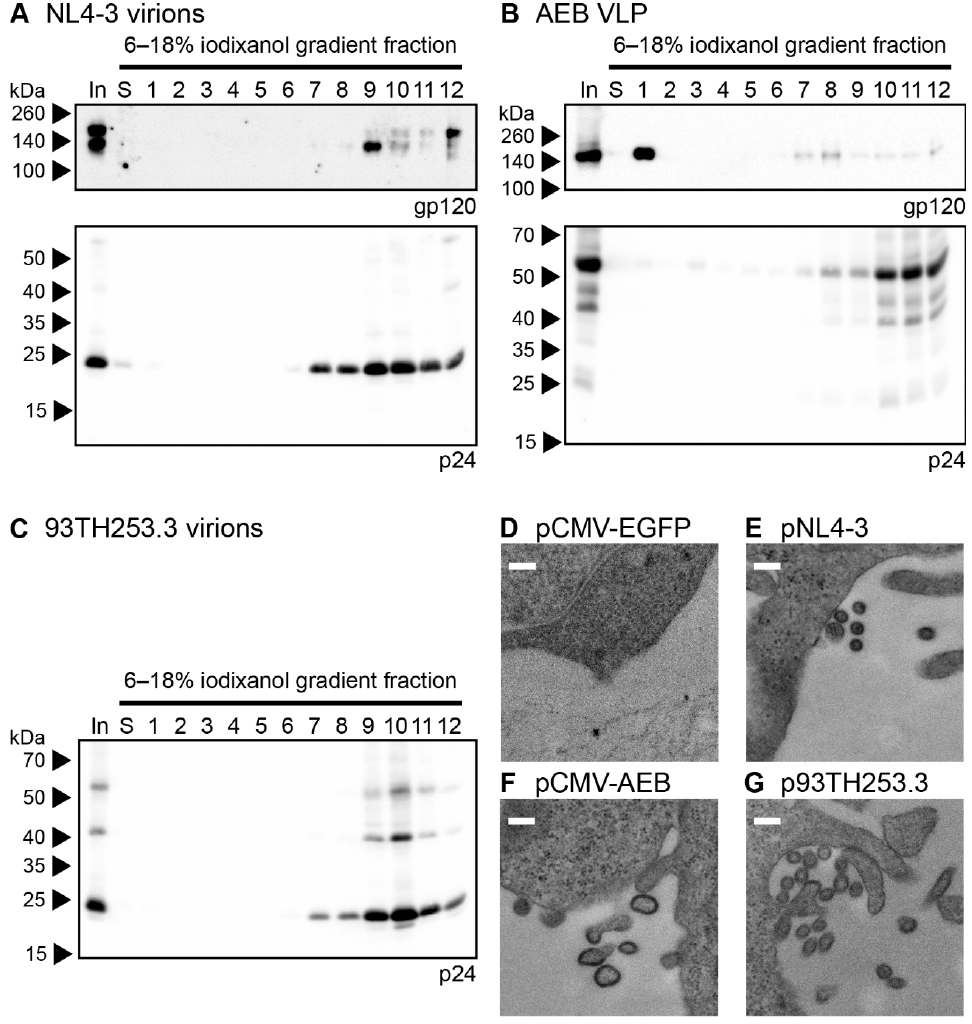
Figure 2. Morphology of AEB VLPs and their parental viruses. Rate velocity centrifugation of ( A ) NL4-3 virions, ( B ) AEB VLPs, and ( C ) 93TH253.3 virions was performed. A sample of the VLP concentrate prior to centrifugation (In), the uppermost iodixanol-free fraction of bu ff er created upon application of sample to the gradient (S), and gradient fractions of increasing density (1–12) were resolved by 6–18% SDS-PAGE before Western blotting using anti-gp120 (DV-012, upper panel) and anti-p24 (BC1071, lower panel). For all panels, protein sizes were indicated by Spectra Multicolor Broad Range Protein Ladder (Thermo Scientific) and are shown on the left. For ( A ) note the absence of an anti-gp120 upper panel due to 93TH253.3 not expressing a functional Env. Representative Western blots are shown. HEK 293T cells transfected with ( D ) pCMV-EGFP, ( E ) pNL4-3, ( F ) pCMV-AEB, and ( G ) p93TH253.3 were imaged scale bar represents 200